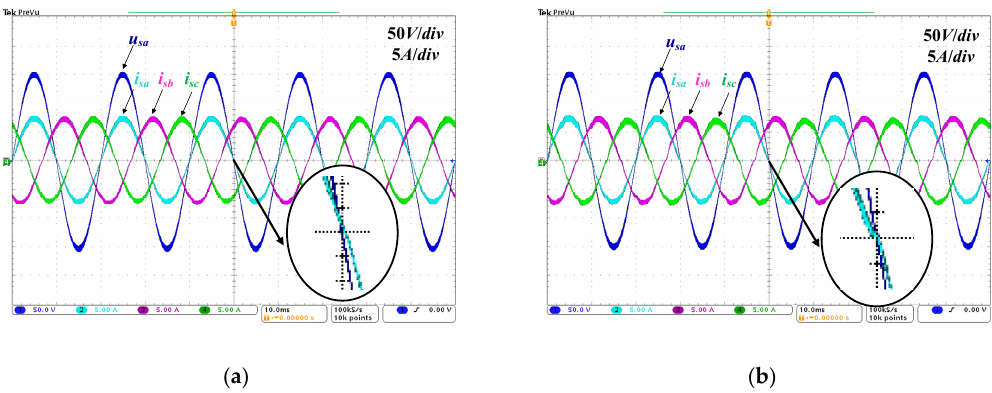
Figure 10. Input current Fourier decomposition; ( a ) H-bridge rectifier; ( b ) Bridgeless rectifier; ( c ) VIENNA rectifier; ( d ) Diode H-bridge boost rectifier.